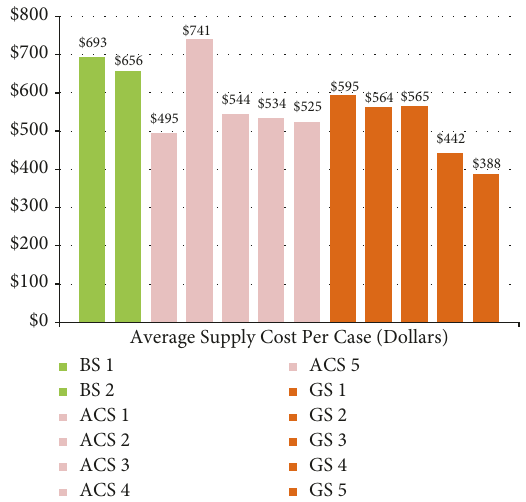
Figure 1: Comparison of average supply cost per case stratified by surgeon and department. The three departments analyzed include bariatric surgery (n=2), acute care surgery (n=5), and general surgery (n=5).